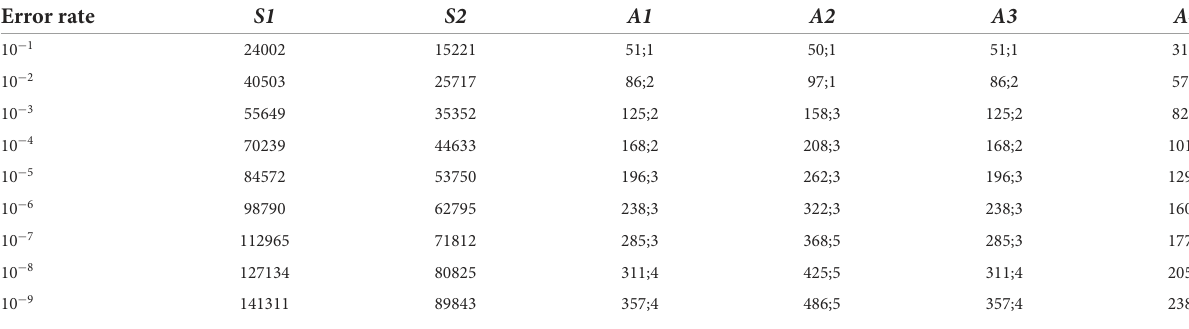
TABLE 2 Estimated memory dimensions to achieve different error